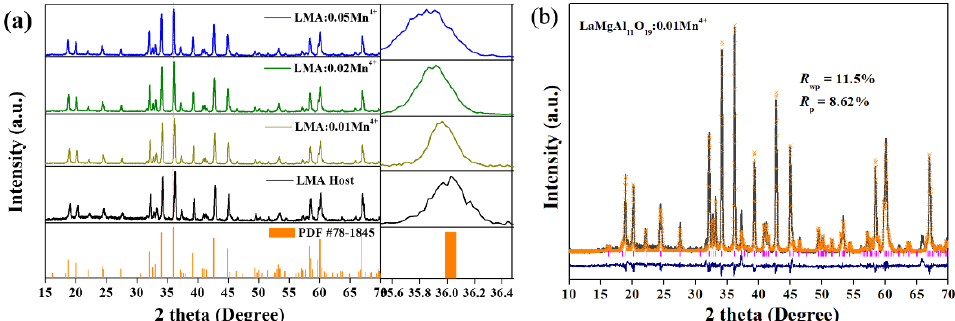
Figure 1. ( a ) X-ray diffraction (XRD) pattern of LaMgAl11O19 (LMA)/xMn 4+ ; ( b ) experimental (black solid line) and calculated (yellow crossed symbol) XRD profiles of LMA/0.01Mn 4+ . The difference profile (blue solid line) and Bragg position (vertical line) are also provided. Table 1. Crystallographic data and refinement parameters of the LMA/0.01Mn 4+ .